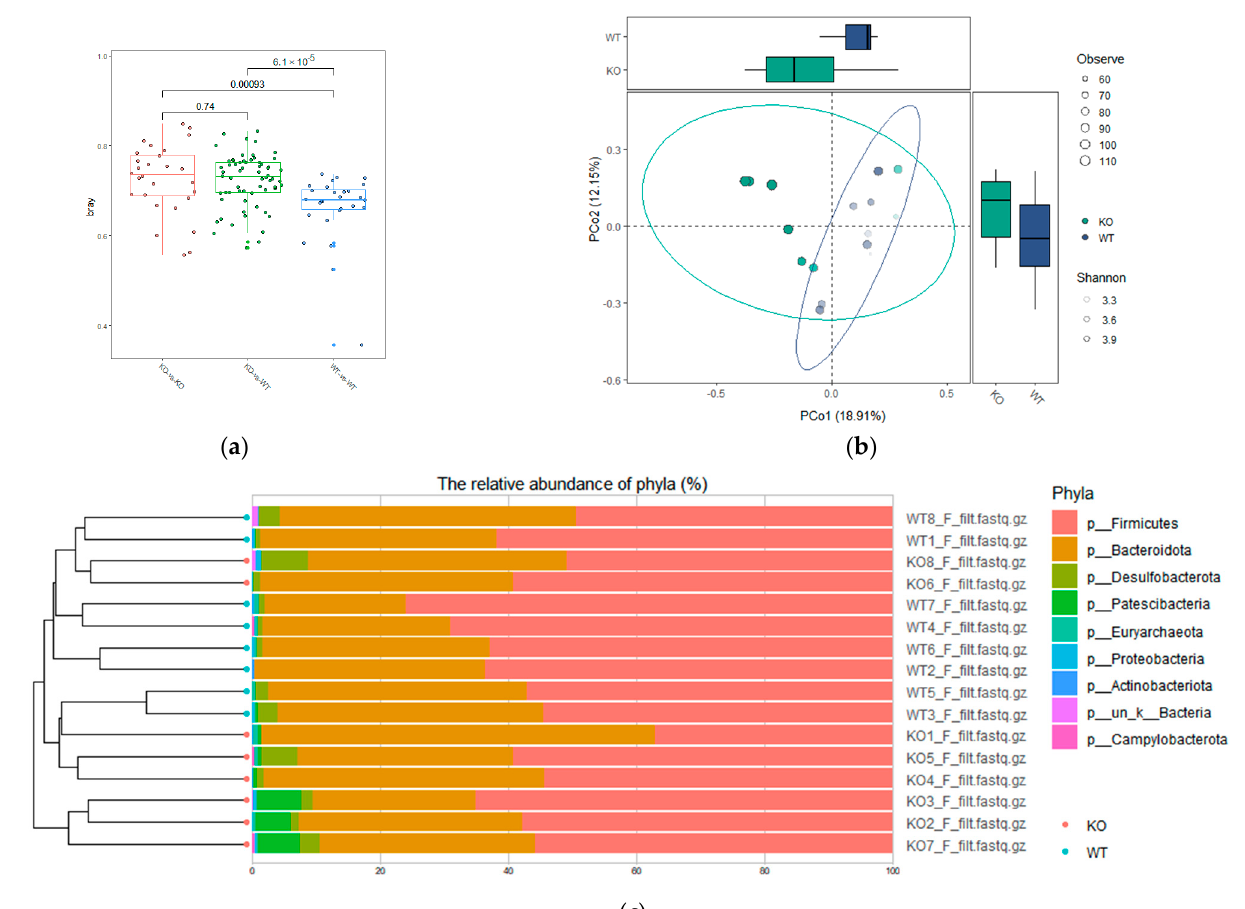
Figure 3. β -diversity among wild-type (WT) and TAAR9-knockout (KO) rats. ( a ) The comparison of Bray–Curtis distance among the groups; ( b ) PCoA of the microbiota composition showing significant difference (Bray–Curtis distances) between TAAR9-KO and wild-type rats ( p = 0.0274); ( c ) the hierarchical cluster result of TAAR9-KO and wild-type samples.